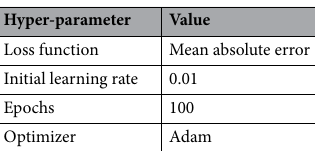
Table 5. Hyper-parameters setting of the proposed